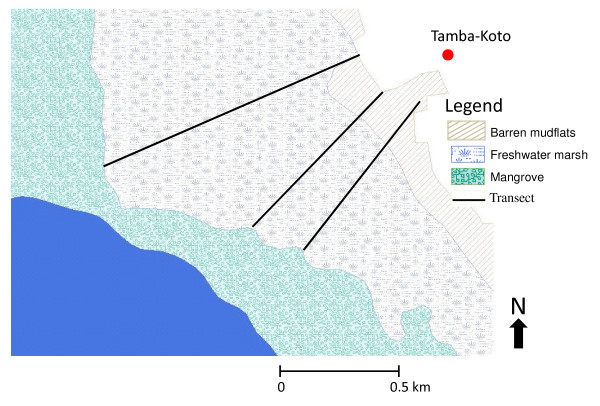
Map of study area.